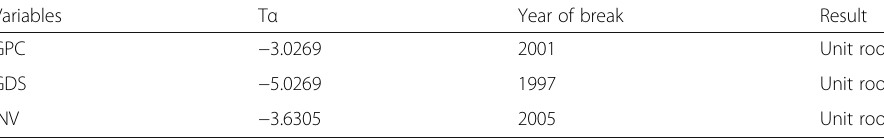
Table 2 Zivot and Andrews test for unit roots with one structural break Variables T α Year of break Result GPC − 3.0269 2001 Unit root GDS −